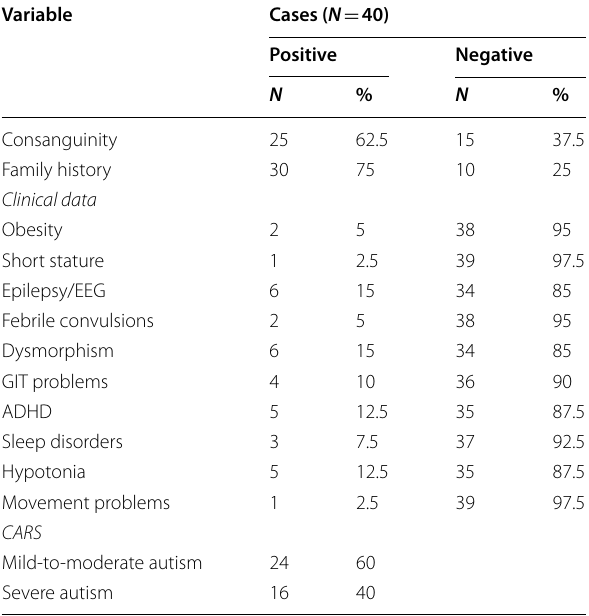
Table 1 History and clinical data of the autistic cases Variable